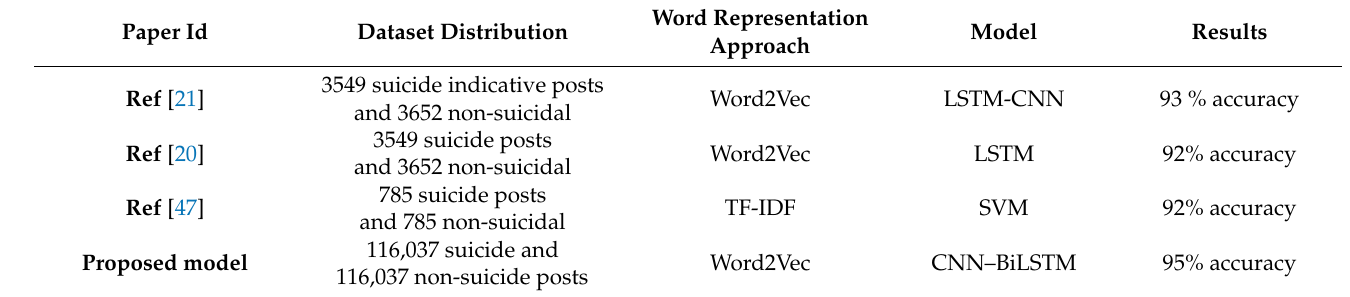
Table 5. Comparative analysis of the performance of proposed model with other existing